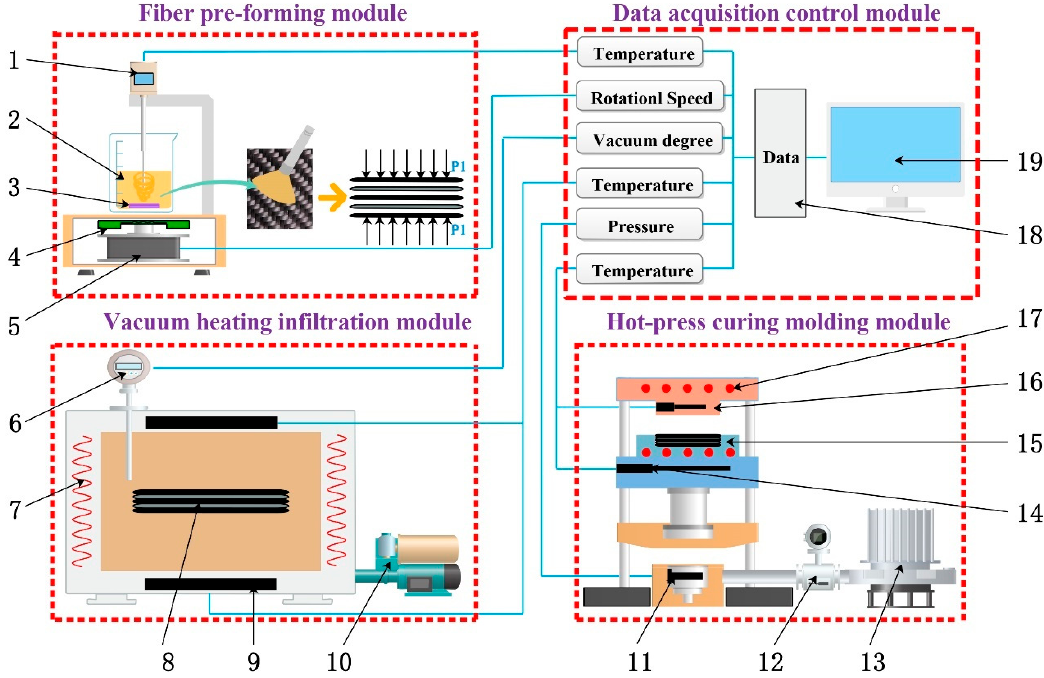
Figure 1. Schematic diagram of the vacuum infiltration hot-press forming experimental system (VIHPS).